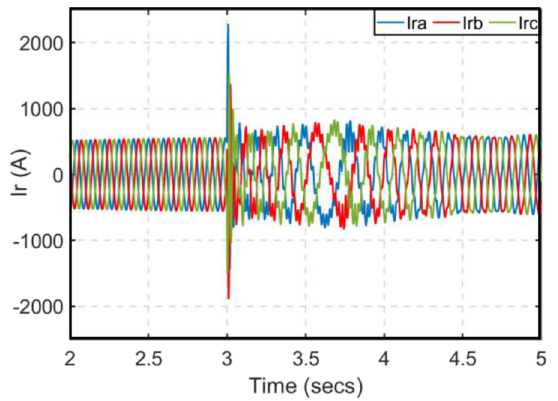
Fig. 13 Evolution of the electromagnetic